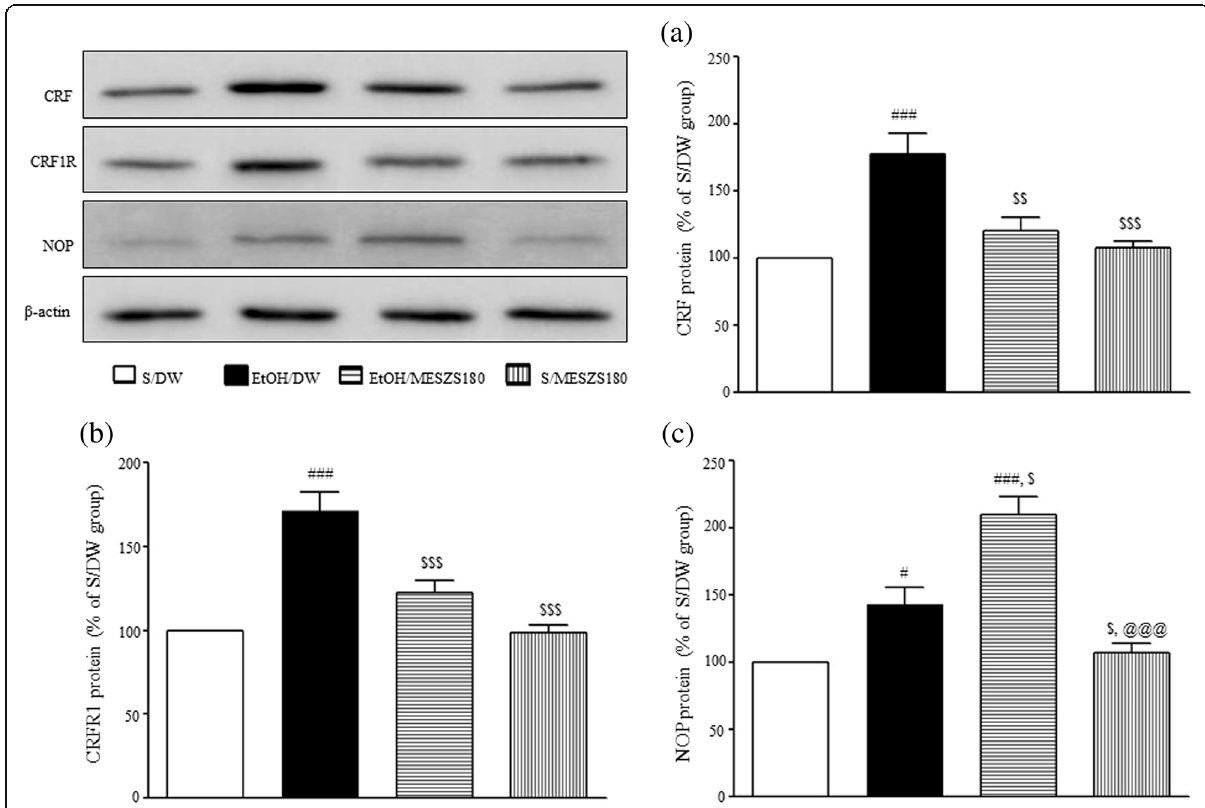
Fig. 6 Effects of MESZS on the protein expressions of amygdaloid ( a ) CRF, ( b ) CRFR1 and ( c ) NOP during EtOHW. Immediately after the behavioral test, the protein expressions of CRF and CRFR1 and NOP in the CeA were detected using Western blot analysis. All data are expressed as a mean ± SEM ( n = 4). S: saline, DW: distilled water, EtOH: ethanol, MESZS: methanol extract of Semen Ziziphi Spinosae , MESZS180: 180 mg/kg/d MESZS. # p < 0.05 and ### p < 0.001 vs. S/DW group; $ p < 0.05, $$ p < 0.01 $$$ p < 0.001 vs. EtOH/DW group; @@@ p < 0.001 vs.